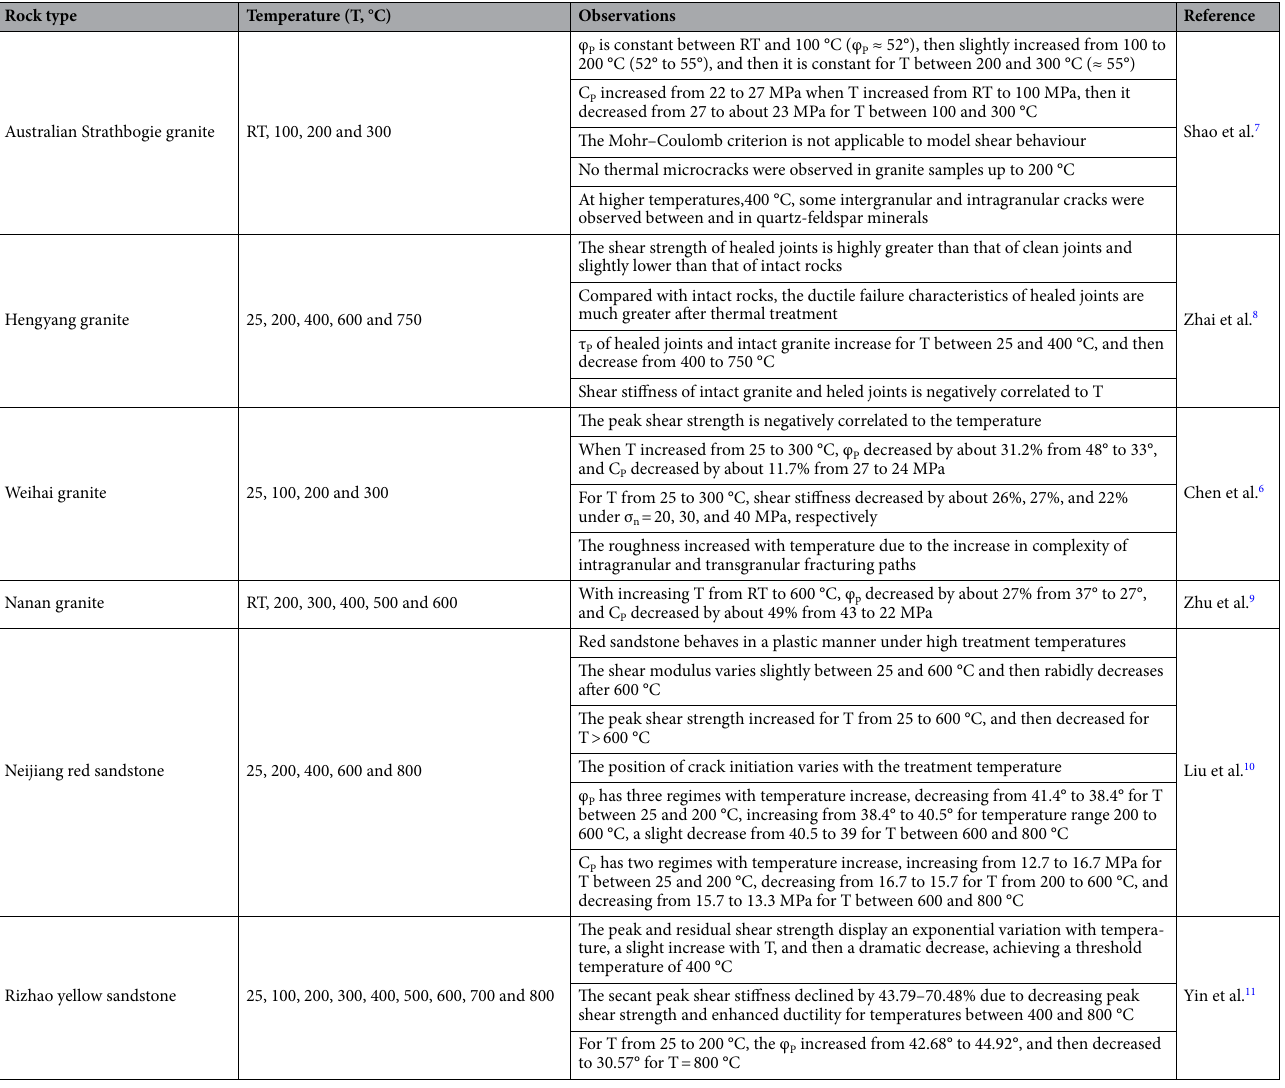
Table 2. A summary of experimental results for the effect of thermal treatment on the shear behaviour of intact